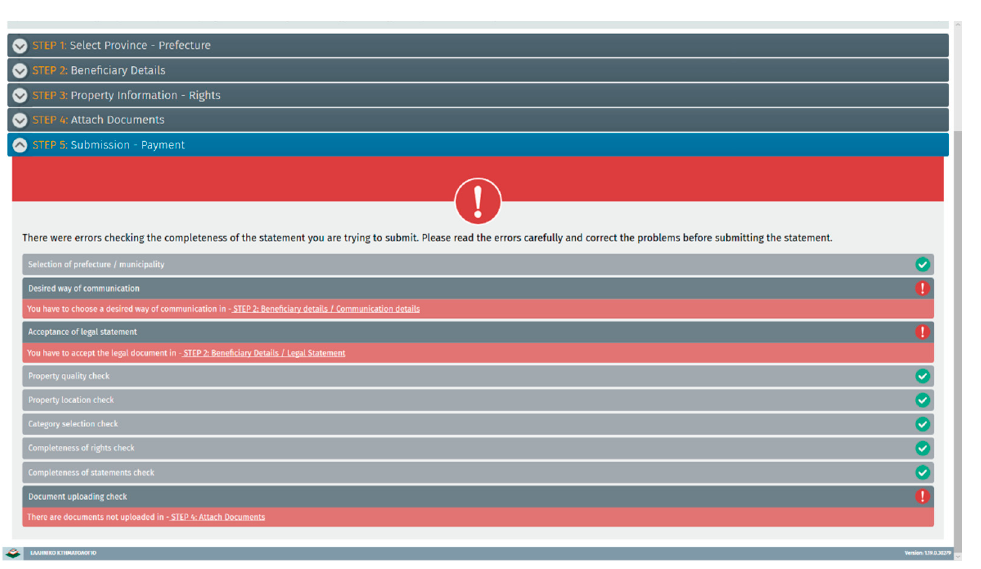
Figure 8. System error validation page. The user must correct all the indicated errors before proceeding.